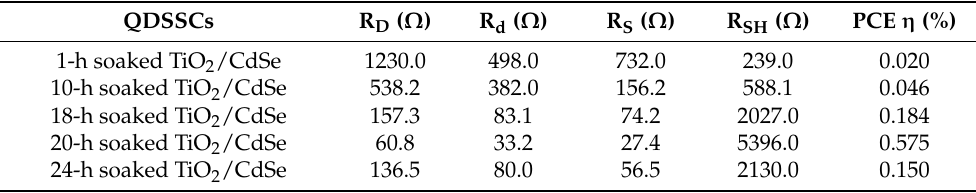
Table 2. The resistance values of QDSSCs as calculated by physical